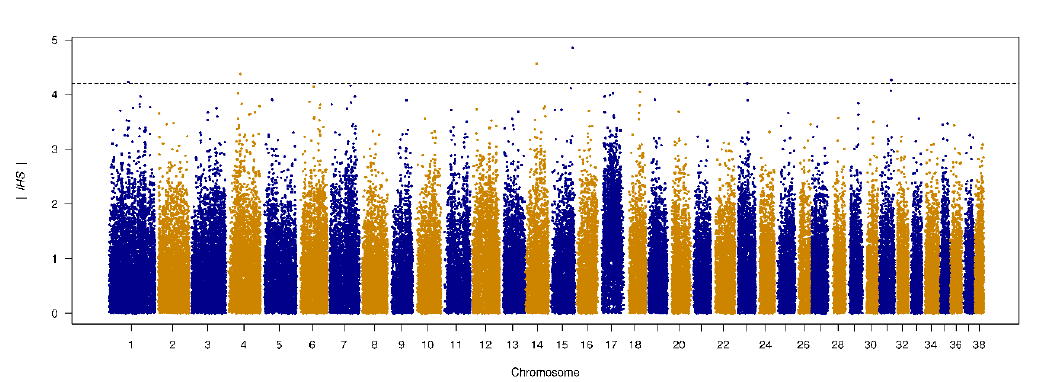
Figure 10. Manhattan plot of genomic selection regions detected using iHS. The strongest signals were detected on chromosomes 15, 14, 4, 31, and 1.